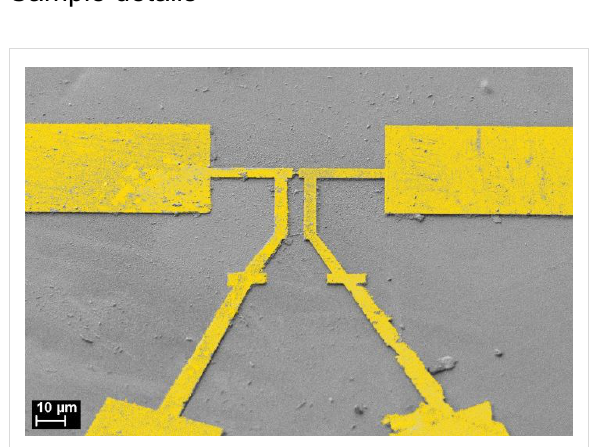
Figure 11: Colored scanning electron micrograph of the sample shown in Figure 2, recorded after the measurements under an angle of 45°.